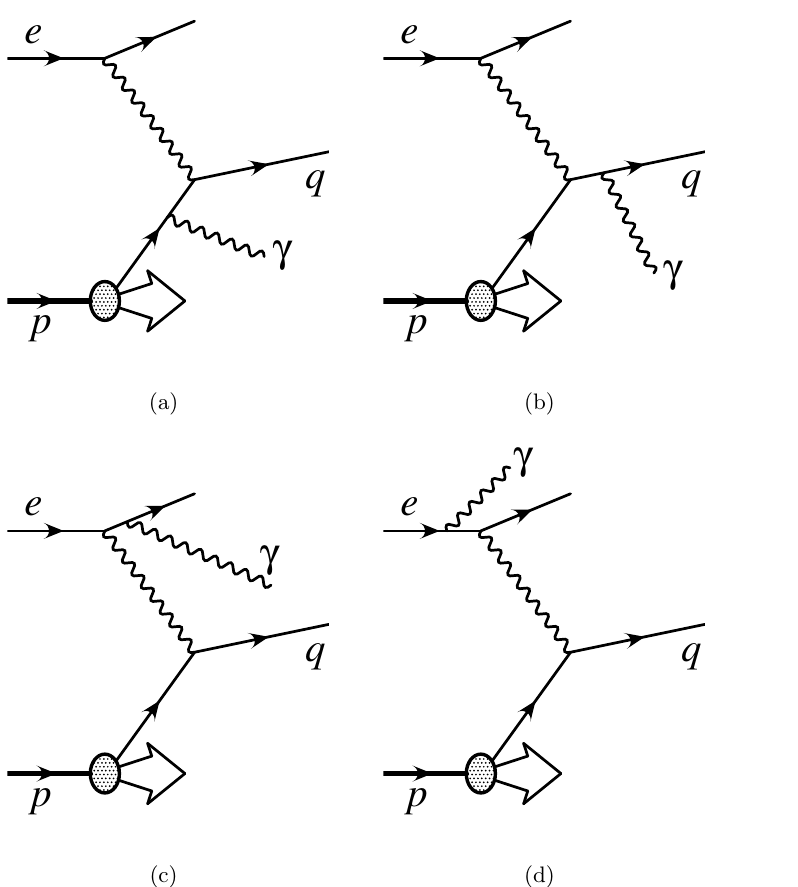
Figure 1 . Lowest-order diagrams for photon production in ep scattering. (a), (b): quark radiative diagrams (QQ); (c), (d): lepton radiative diagrams